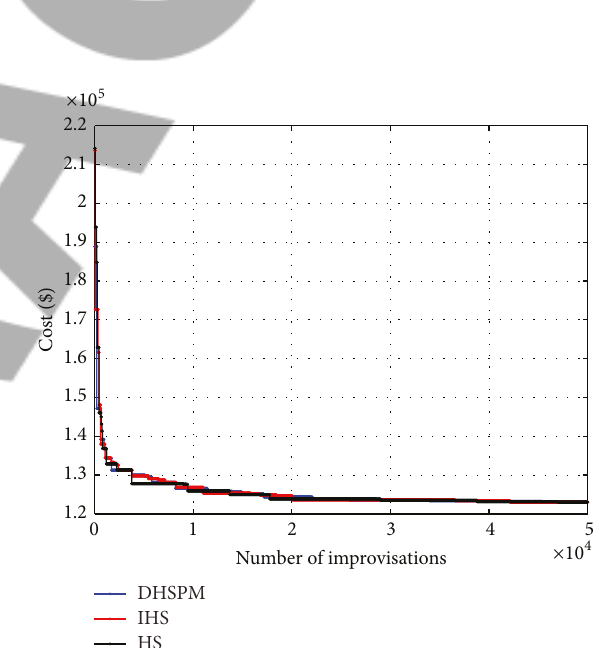
Figure 4: Fuel cost convergence nature of DHSPM, IHS, and HS for 13 thermal units’ system.